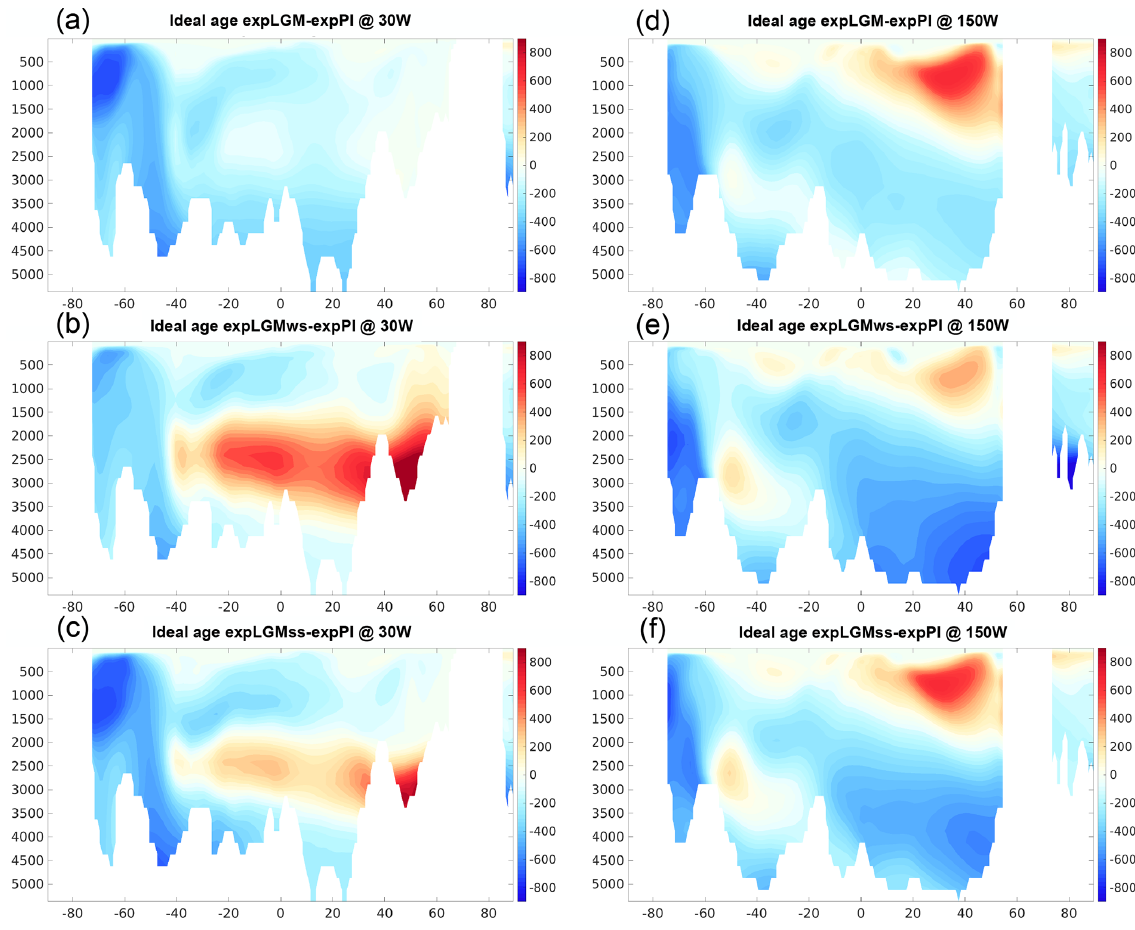
Figure 8. Meridional sections in the Atlantic ( a–c ; at 30 ◦ W) and in the Pacific ( d–f ; at 150 ◦ W) of the simulated ideal age of seawater in the LGM experiments (years): expLGM (a, d) , expLGMws (b, e) , and expLGMss (c, f) . The differences between each LGM experiment and expPI are shown. The average states of the last 50 years are